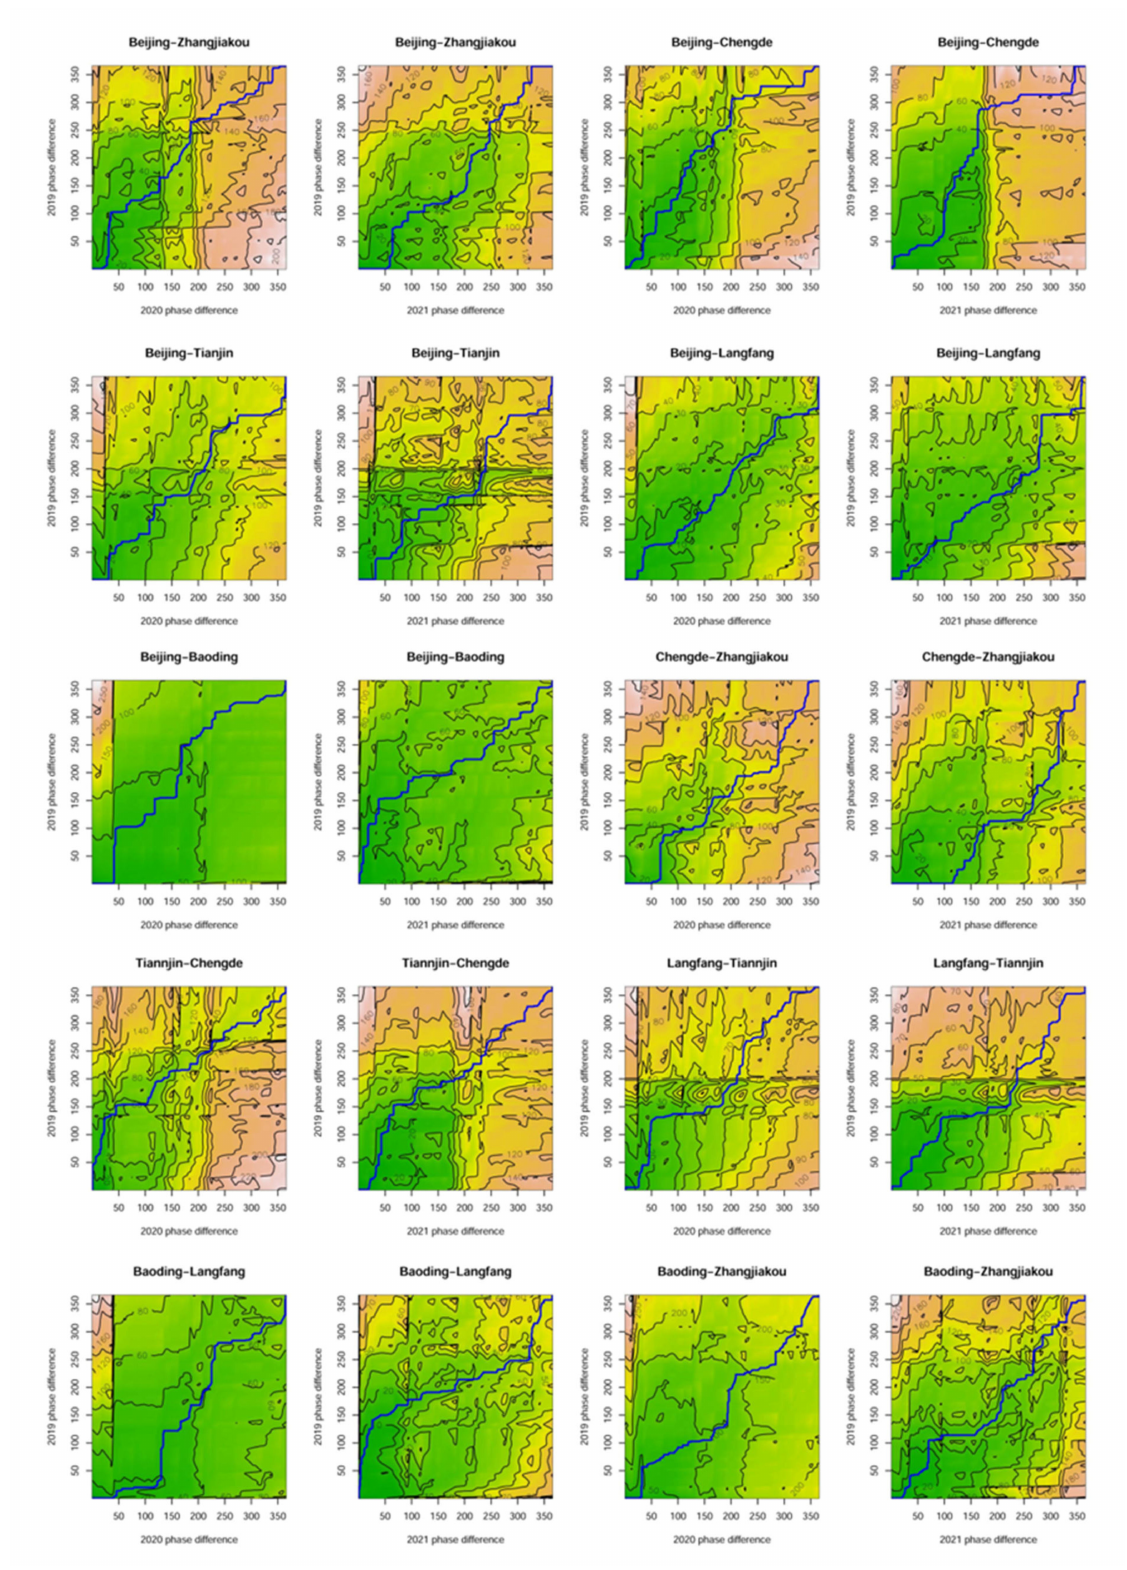
Figure 6. Cost density plot: average per-step cost density of the sine–cosine global alignment. Note: the color filling represents the position of the match of DTW, and the blue line represents the shortest distance. The study took 2019 (before the epidemic) as the reference for comparison and compared 2020 with 2021 and 2019, respectively. The horizontal and vertical axes represent the day of the year